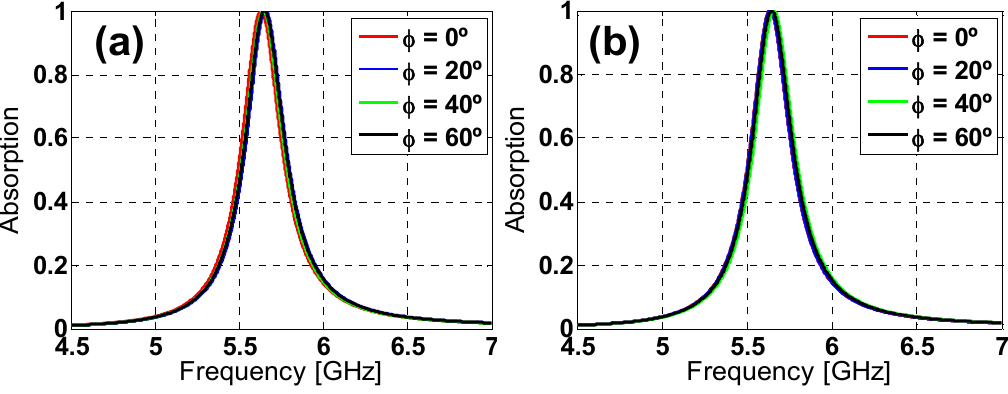
Figure 4. Star design absorption simulation results for different polarization angles ( ϕ ) of the incident field for both ( a ) TE and ( b ) TM